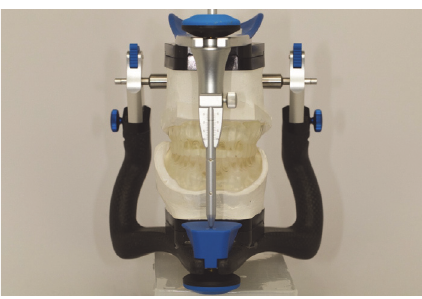
Figure 7: First prototype.